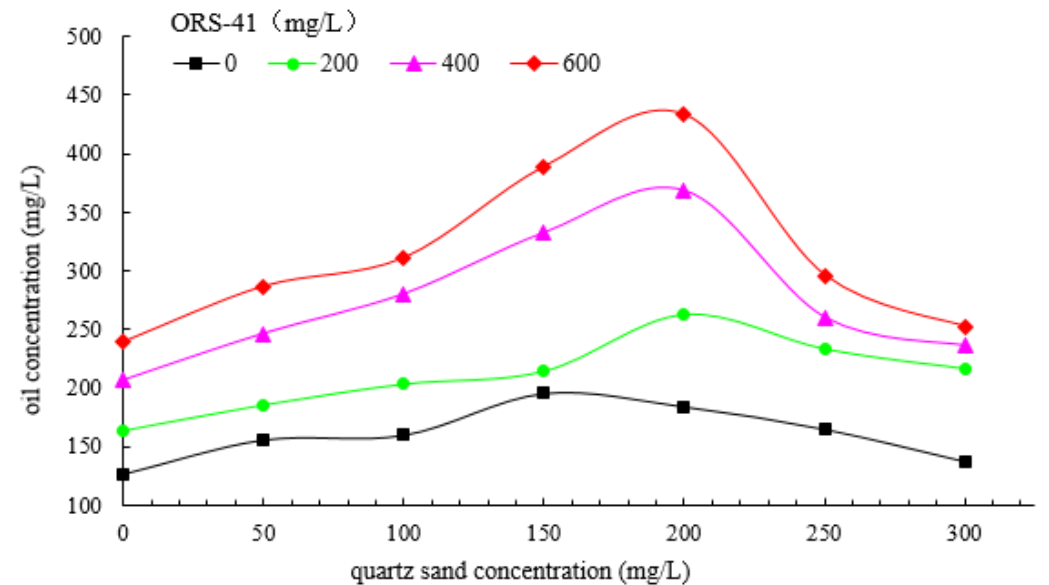
Figure 4. The synergetic effect of surfactant and quartz sand particles on oil–water separation (polymer concentration 500 mg/L, alkali concentration 600 mg/L).